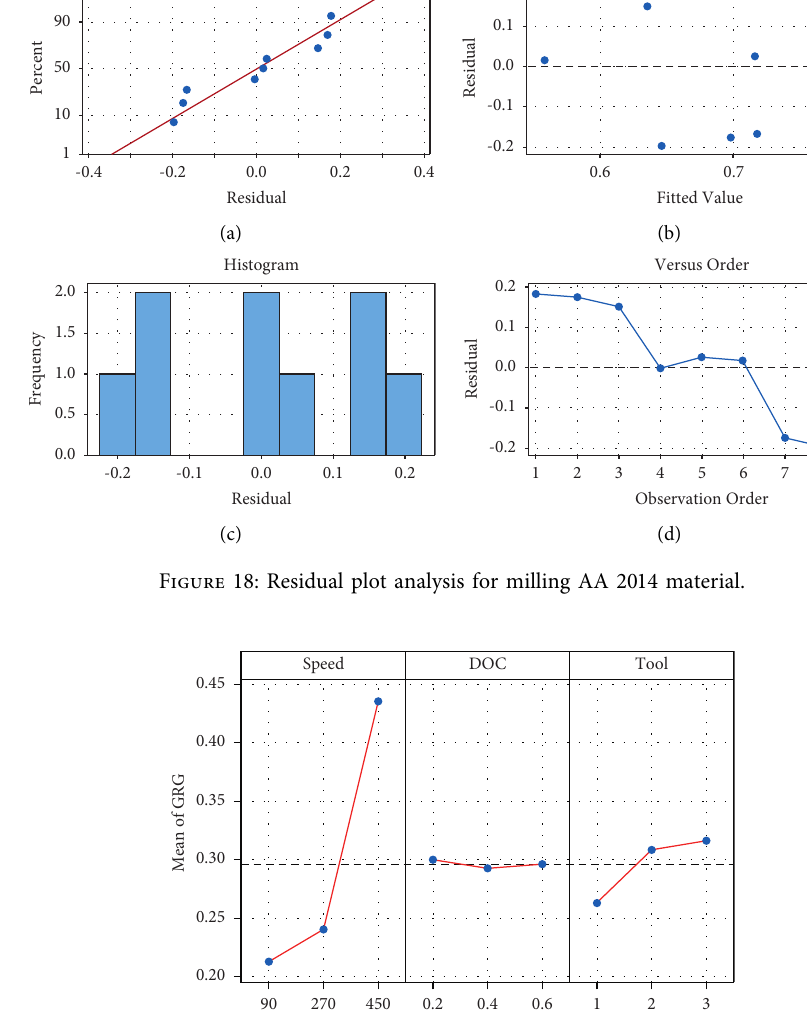
Figure 19: Main effect variation plot of GRG values for the process